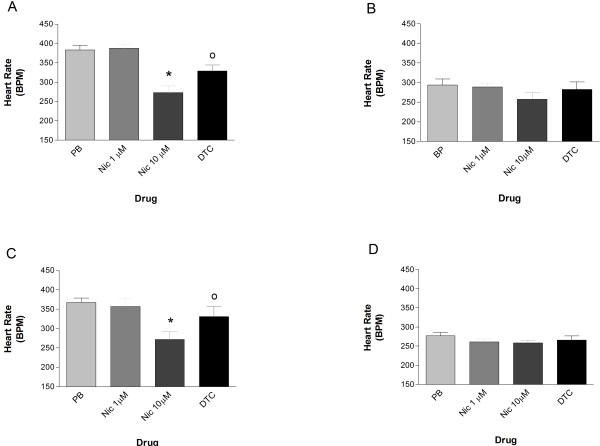
Nicotine affects the heart rate of anesthetized whole-animals. 10 μM Nicotine (Nic) induced a significant bradycardic response, while 1 μM D-tubocurarine reversed it, in both healthy (A) and chagasic (C) rats. Lower doses of Nic (i.e., 1 μM) have no effect on the heart rate of these animals. EKG results from healthy (B) and chagasic (D) rats, treated daily with 1 mg/Kg of reserpine for 3 days, showed a significant decrease of heart rate compared to untreated animals; however, 10 μM of nicotine has no bradycardic effect on reserpine-treated healthy (B) or chagasic (C) animals.